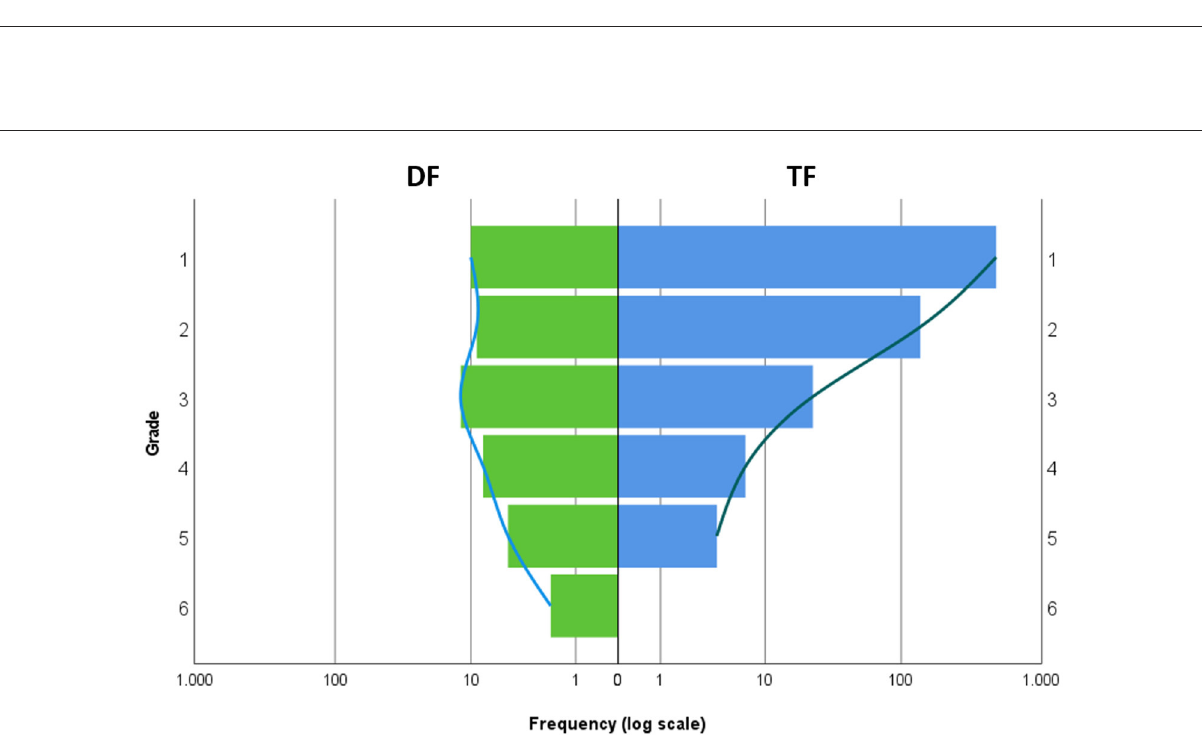
FIGURE1 Comparison of DF and TF with respect to the frequency of the exam scores. Left/green: DF, right/blue: TF. The x axis shows the frequency of each score displayed on the y axis. To account for the different sample sizes of DF and TF, a logarithmic scale was used for the x axis.